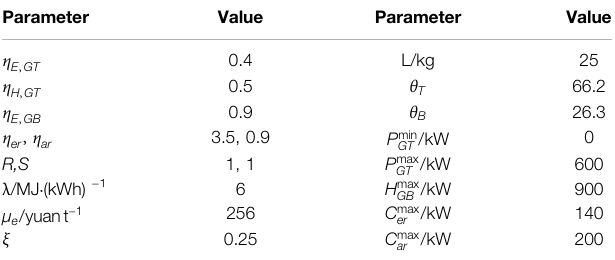
Figure 5 . The parameters of AA-CAES are depicted in Table 1 , and the rated charging time and rated discharging time are 10 h. The internal equipment parameters of the IES are shown in Table 2 .